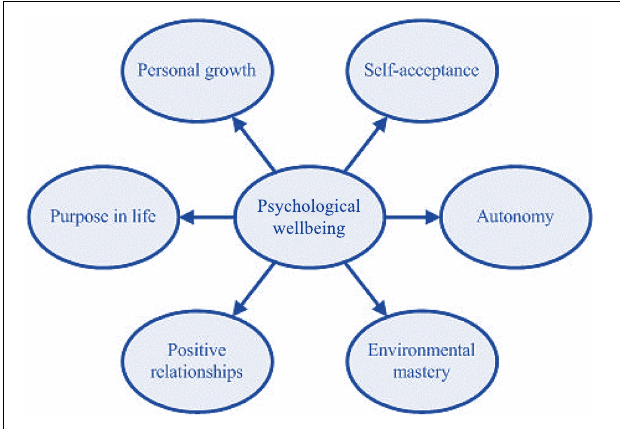
FIGURE 1 | Dimensions of the psychological wellbeing (Ryff,